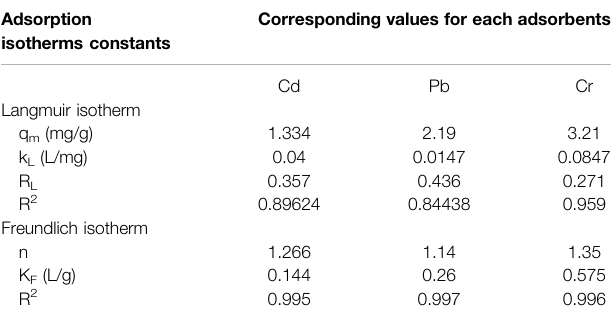
TABLE 5 | Calculated isotherm parameters for the adsorption of Pb, Cd, and Cr on Cu-DPA MOF at 300 K. Adsorption Corresponding values for each adsorbents isotherms constants Cd Pb Cr Langmuir